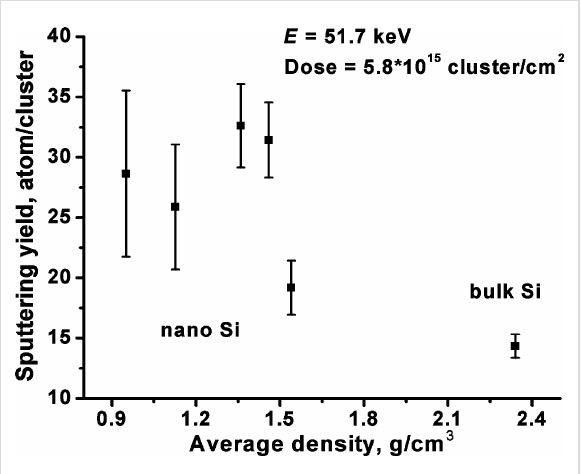
Figure 2: Sputtering yield versus the average density of the pressed nanopowder. Data on bulk Si is also shown. The cluster ion energy is 51.7 keV and the ion dose is 5.8 × 10 15 cluster/cm 2 .